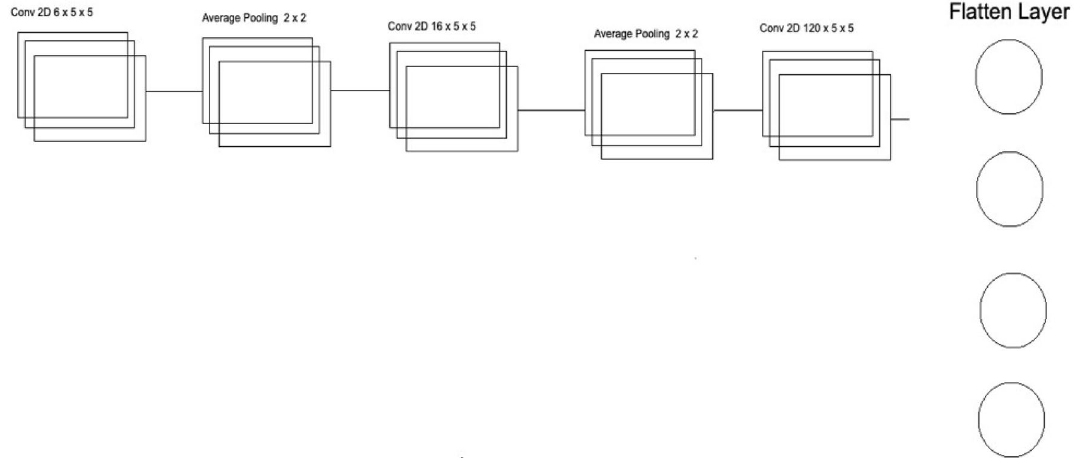
Figure 7. Convolutional neural network two